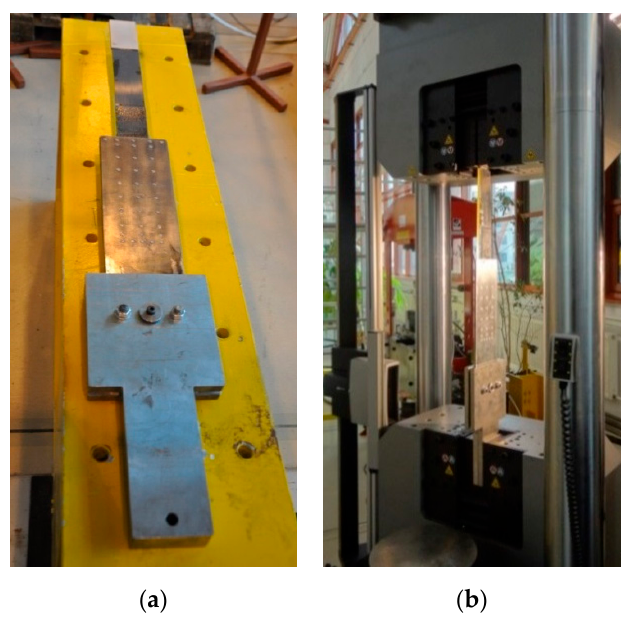
Figure 10. Anchorage specimen installed in the testing machine jaws ( a ) and the testing machine ( b ).